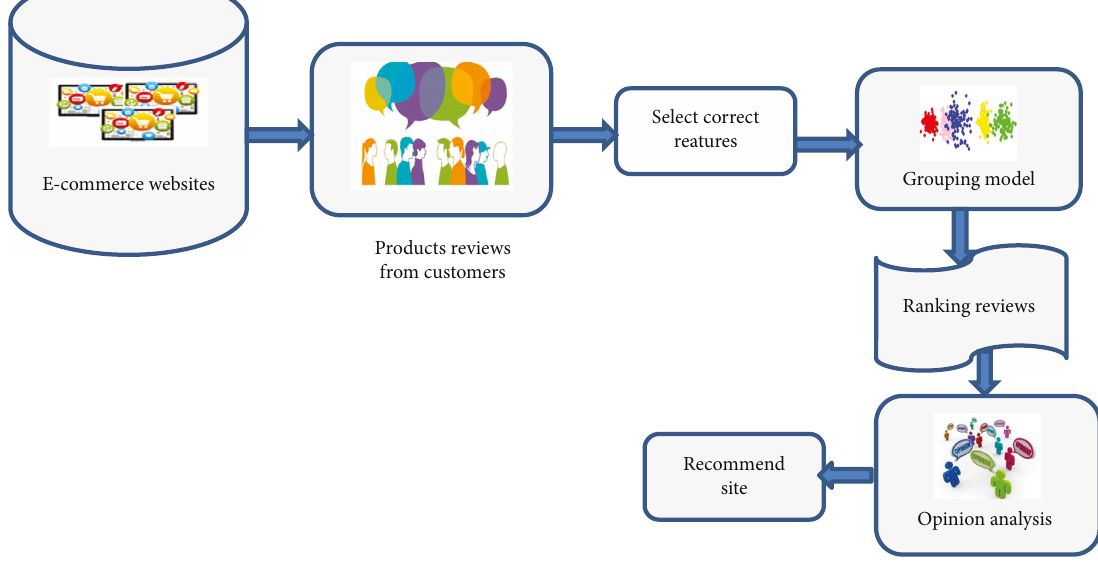
Figure 1: Diagram of the opinion mining